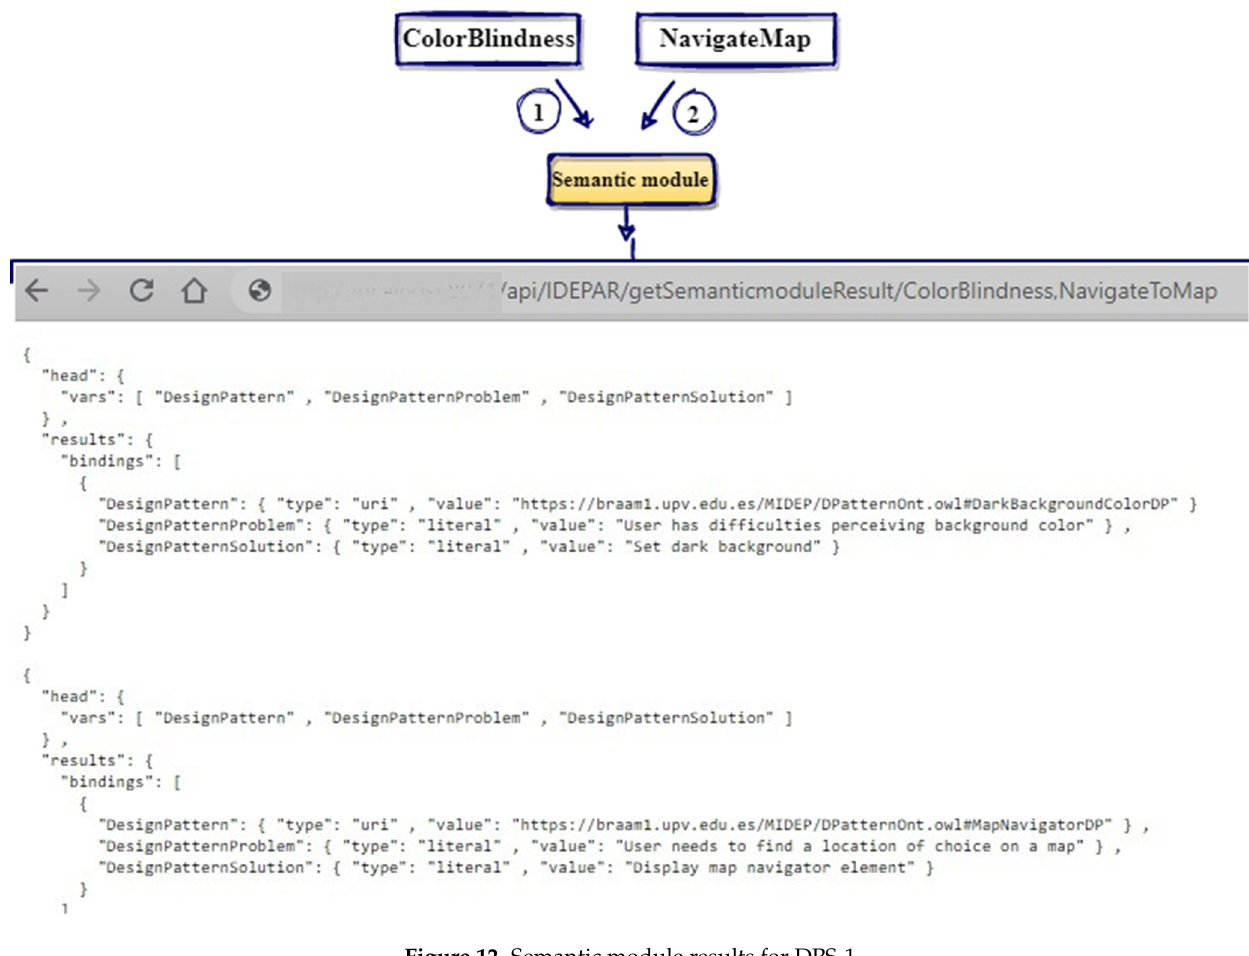
Appl. Sci. 2021 , 11 , x FOR PEER REVIEW